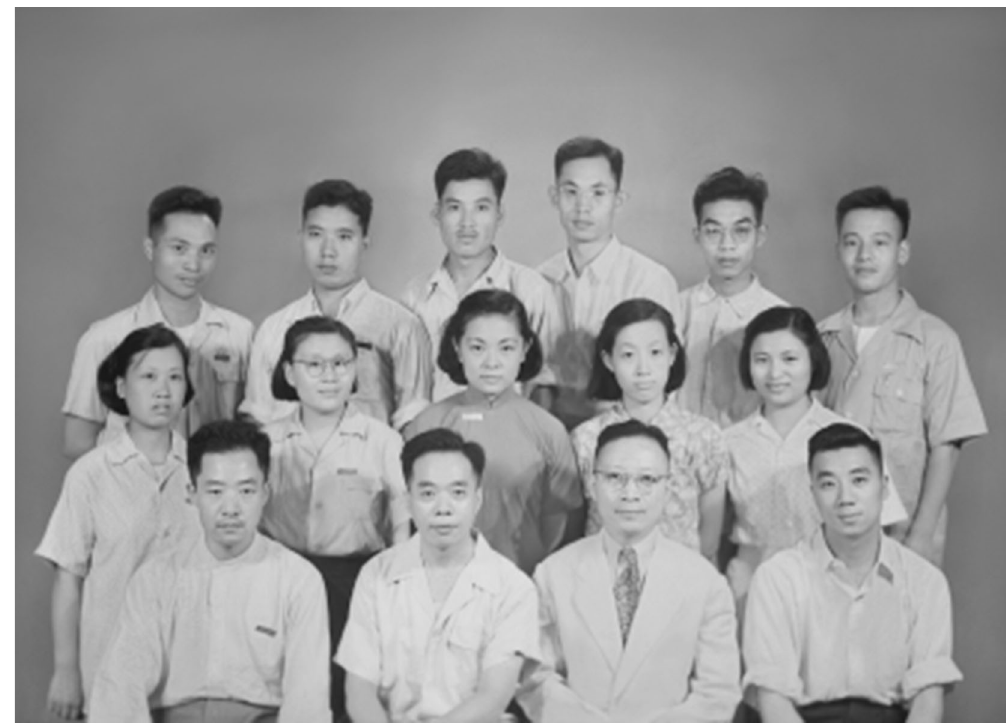
Figure 2. Faculty and Students from PUMC Pathological Senior Teacher Training Program in 1952, Tonghua Liu is the third in the second row, Prof. Zhengxiang Hu is the third in the front